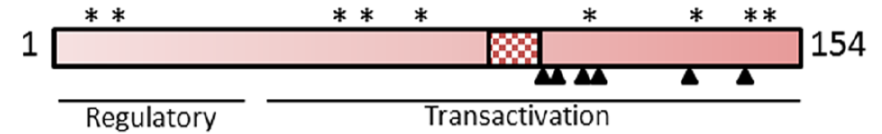
Figure 3. Schematic representation of HBx. The 154-aa HBx protein is conserved in all mammalian hepadnaviruses. Functional domains shown include the regulatory domain (aa 1–50), the transactivation domain (aa 50–154), and the DDB1 binding domain (aa 88–100; hatched area). The proteasome binding domain (aa 90–154) spans the DDB1 binding domain [69]. Conserved cysteine residues are shown by the asterisks (aa 7, 17, 61, 69, 78, 115, 137, 143, and 148) [70] and have an unknown function. Six conserved lysine residues, which may be targets for ubiquitination, are indicated as filled triangles (aa 91, 95, 113, 118, 130, 140)